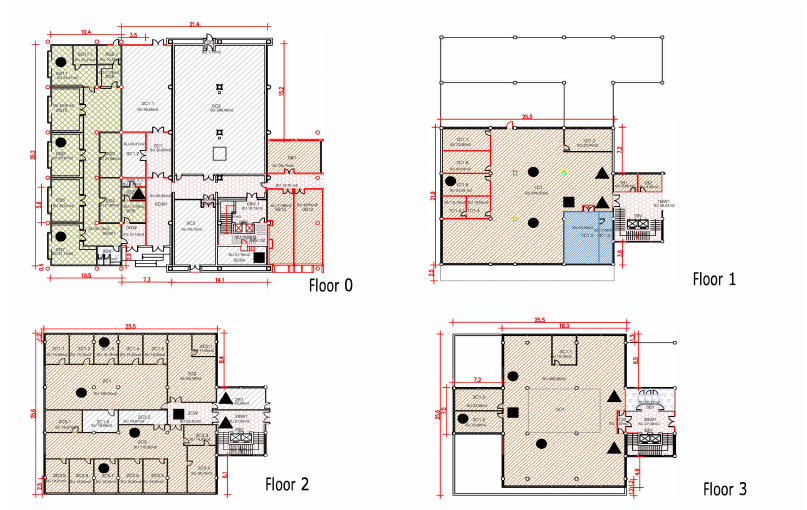
Figure 2. Plans of the four floors in the west block of the building with their space distribution and dimensions. The use of each space is represented with colours: offices (brown), nursery (green), storage rooms (grey), corridors (pink) and server room (blue). In addition, the distribution of the sensors is also displayed: circles, illuminance, temperature and relative humidity; triangles, calorimeters; and square, lighting